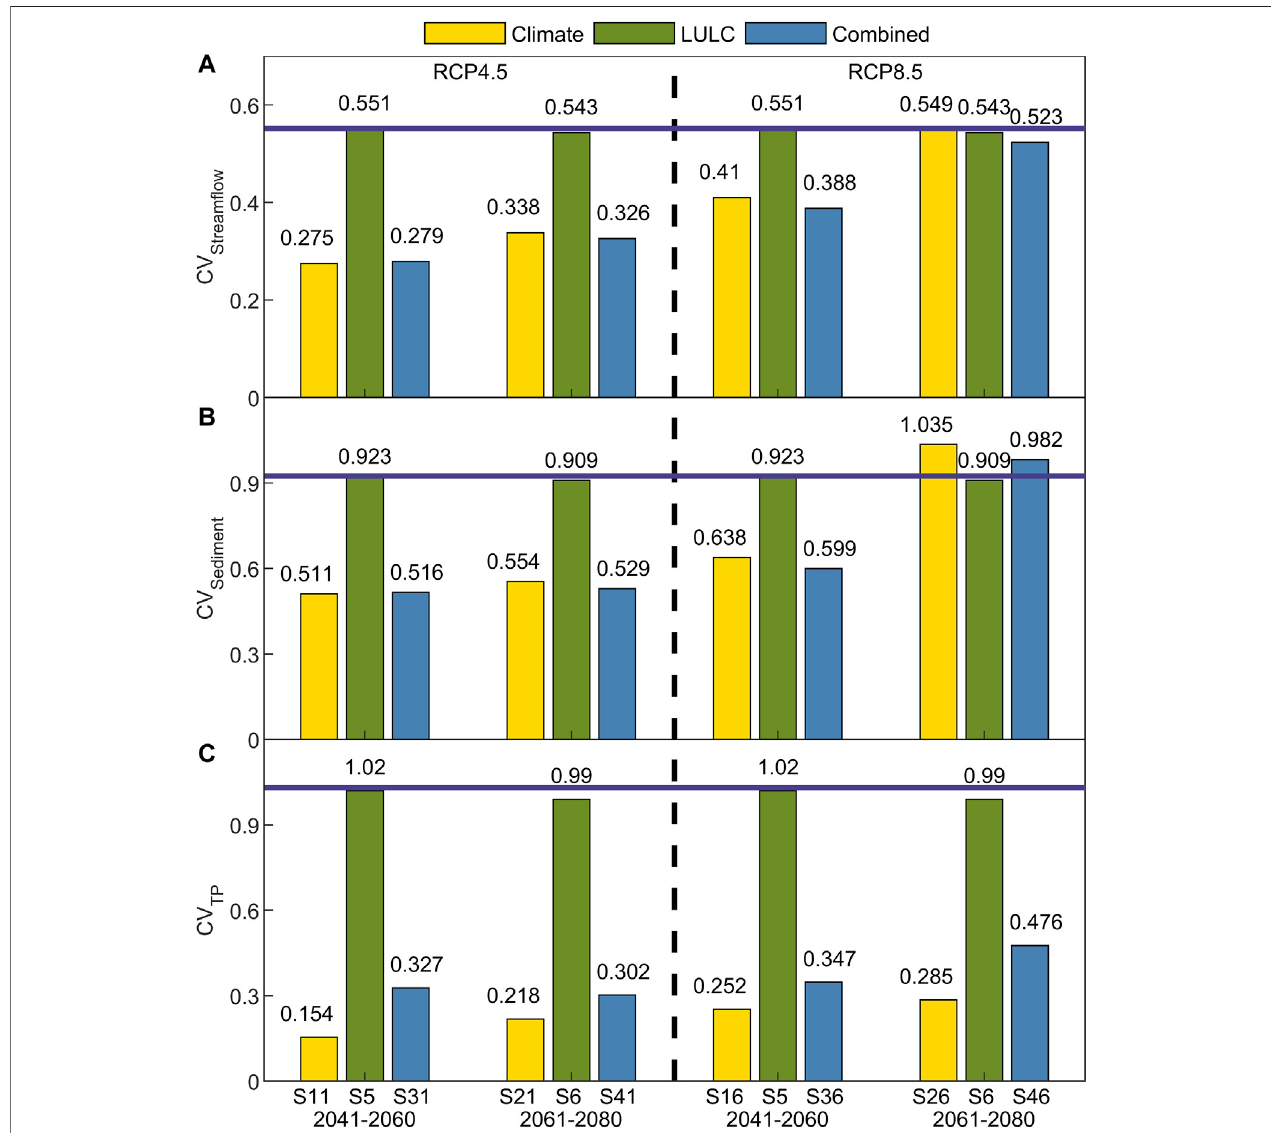
FIGURE7| TheCoef fi cientofVariationofannualstream fl ow,sediment,andTPloadsundervariousscenarios(Thicksolidlinerepresentsthecoef fi cientofvariation in baseline